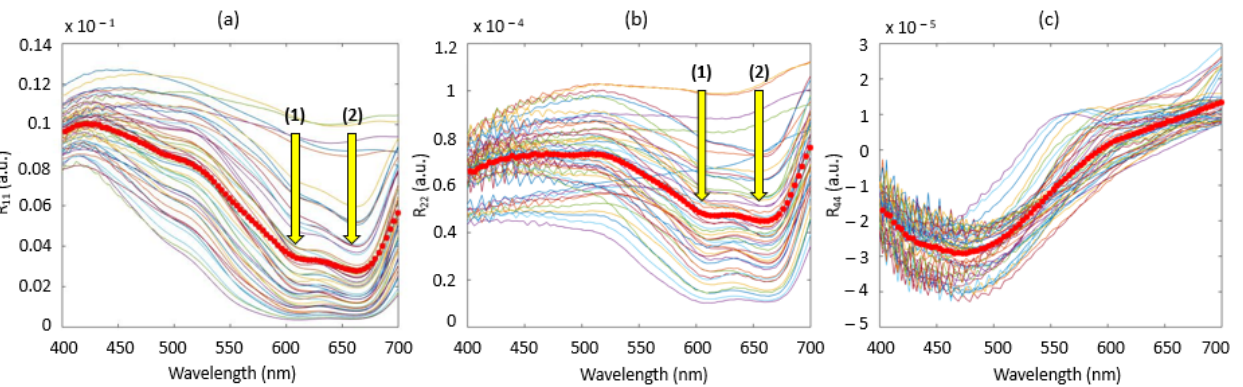
Figure 4. Results of r 11 ( a ), r 22 ( b ) and r 44 ( c ) diffuse reflectance spectra for the M 11 , M 22 and M 44 elements of the Mueller matrix diagonal, respectively. The yellow arrows (1) and (2) in figures ( a ) and ( b ) indicate the two absorption peaks of methylene blue at 609 nm and 668 nm, respectively.